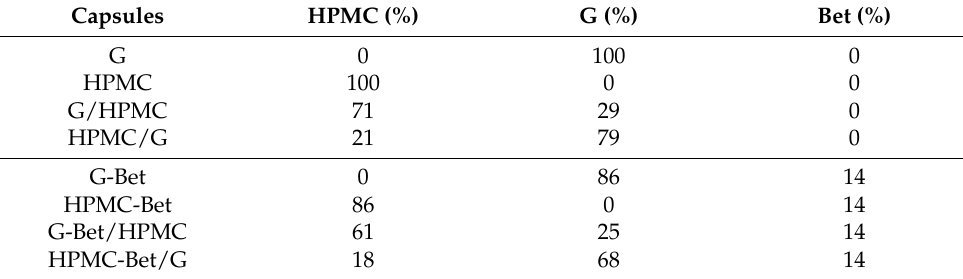
Table 1. Theorical composition of the electrosprayed